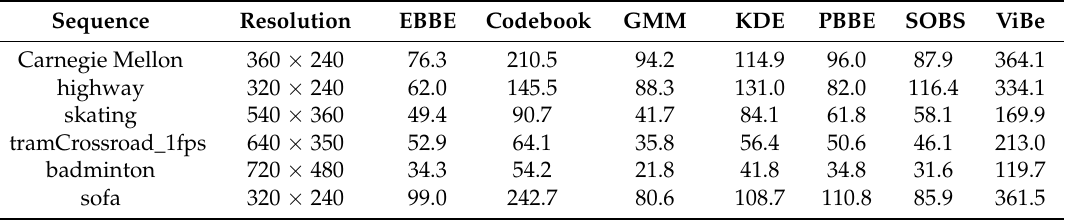
Table 5. Comparison of processing speeds expressed in frames per